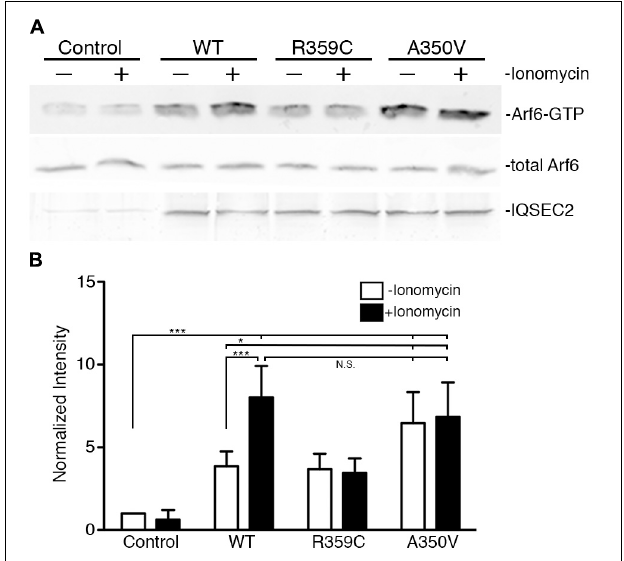
FIGURE 4 | The A350V mutation activates ARF-GEF activity of IQSEC2. (A) WT, R359C, or A350V IQSEC2 was expressed in HEK293 cells, and treated with either ionomycin or carrier control. Activation of endogenous Arf6 under each condition was assayed in cell lysates by pull-down with GGA3. Precipitates were probed with antibodies against ARF6 (top row). Lysates were probed for total Arf6 expression and with antibodies against the FLAG tag on IQSEC2. (B) Arf6-GTP levels are calculated as fold increase over sham-transfected controls and are shown as mean ± SD from six independent experiments. The GGA pulldown assay was assessed by one-way ANOVA followed by Tukey’s Multiple Comparison Test for post